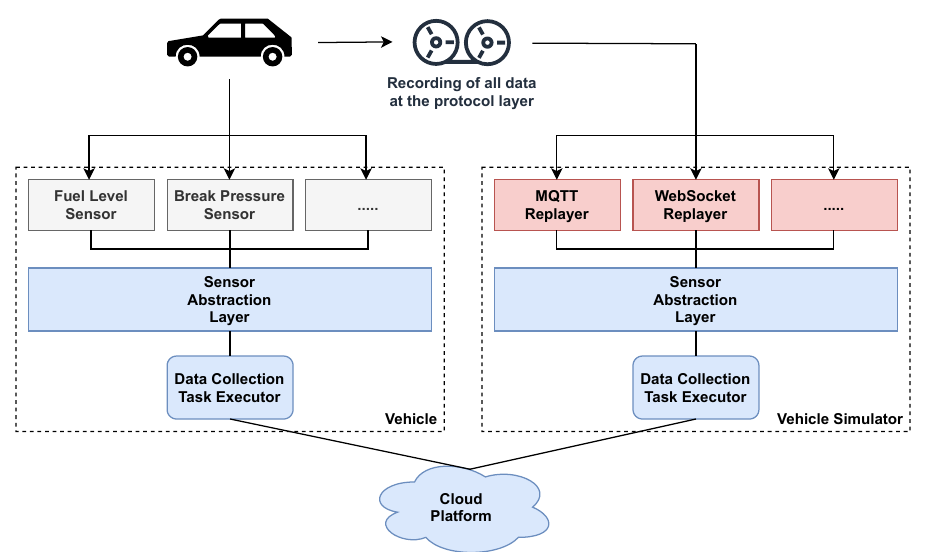
Figure 6. Implementation of a vehicle simulator. It executes the same software as the car. We provide simulated data-access channels that can replay arbitrary recordings from actual